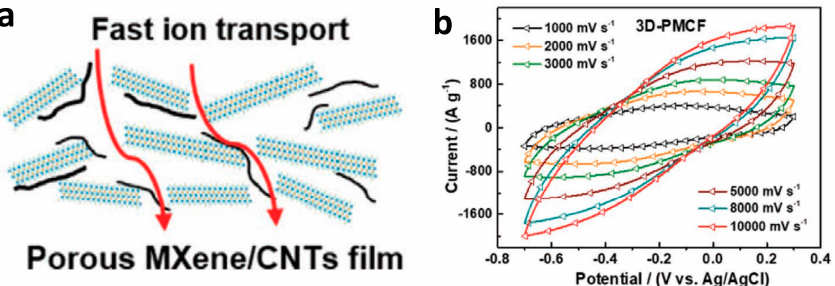
Figure 8. ( a ) Schematic illustration of ion diffusion pathways across the porous MXene/CNTs film. ( b ) CV curves of porous MXene/CNTs film at the different scan rates ranging from 1000 to 10,000 mV s − 1 ; reproduced from [48], with the permission of